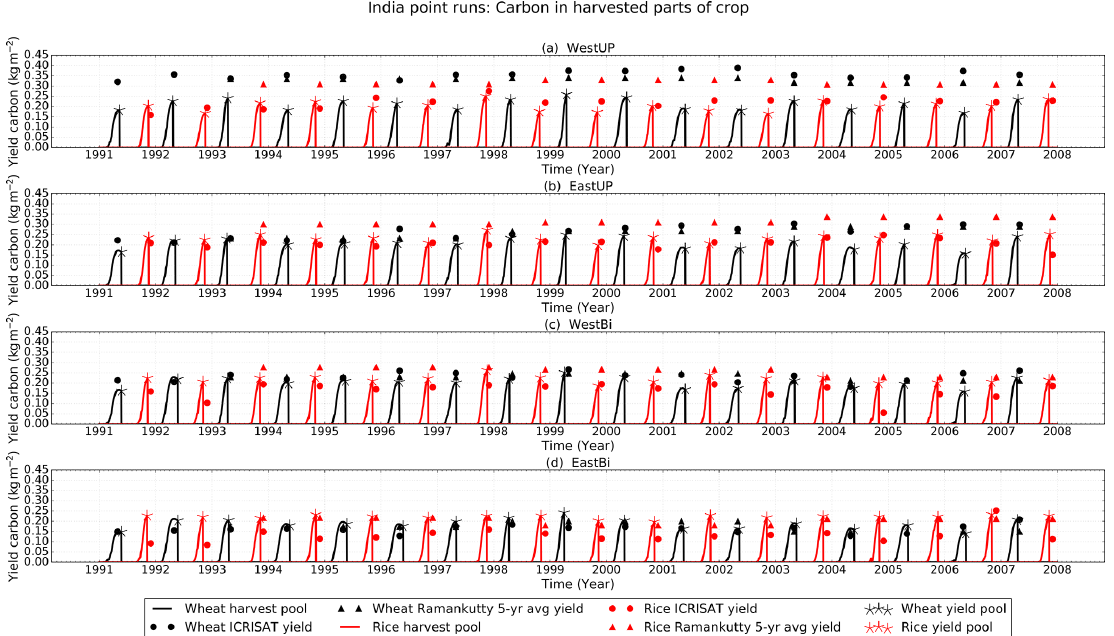
Figure B2. Time series of crop harvest pool (solid lines) with the JULES yield from the sequential-crop run at the time it is output by the model (asterisks) for rice (red) and wheat (black) at each of the India locations shown in Fig. 3. Also shown are two sets of observations: annual yields from ICRISAT (2015) shown by the filled circles and 5-year averages from Ray et al. (2012a) shown by the filled triangles (following the same colours with rice shown in red and wheat in black).